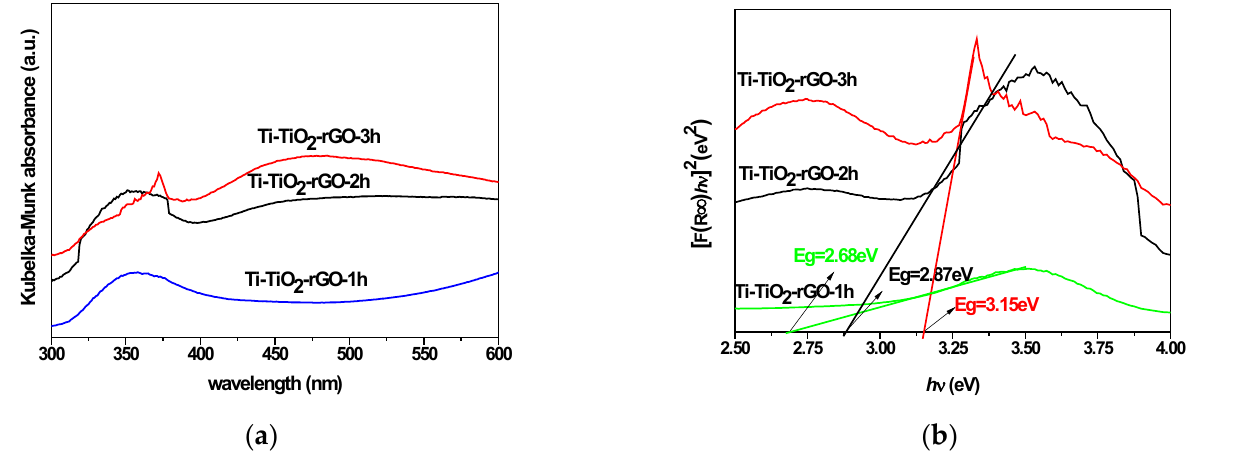
Figure 4. Kubelka–Munk absorbance for the Ti-TiO 2 -rGO composites ( a ); plot of [F(R)*h ν ] 2 versus the energy for composites structures ( b ).